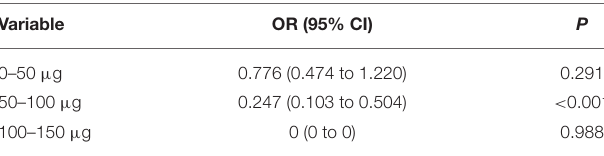
TABLE 5 | Multivariable logistic regression analysis of different dose range of dexmedetomidine for PONV.